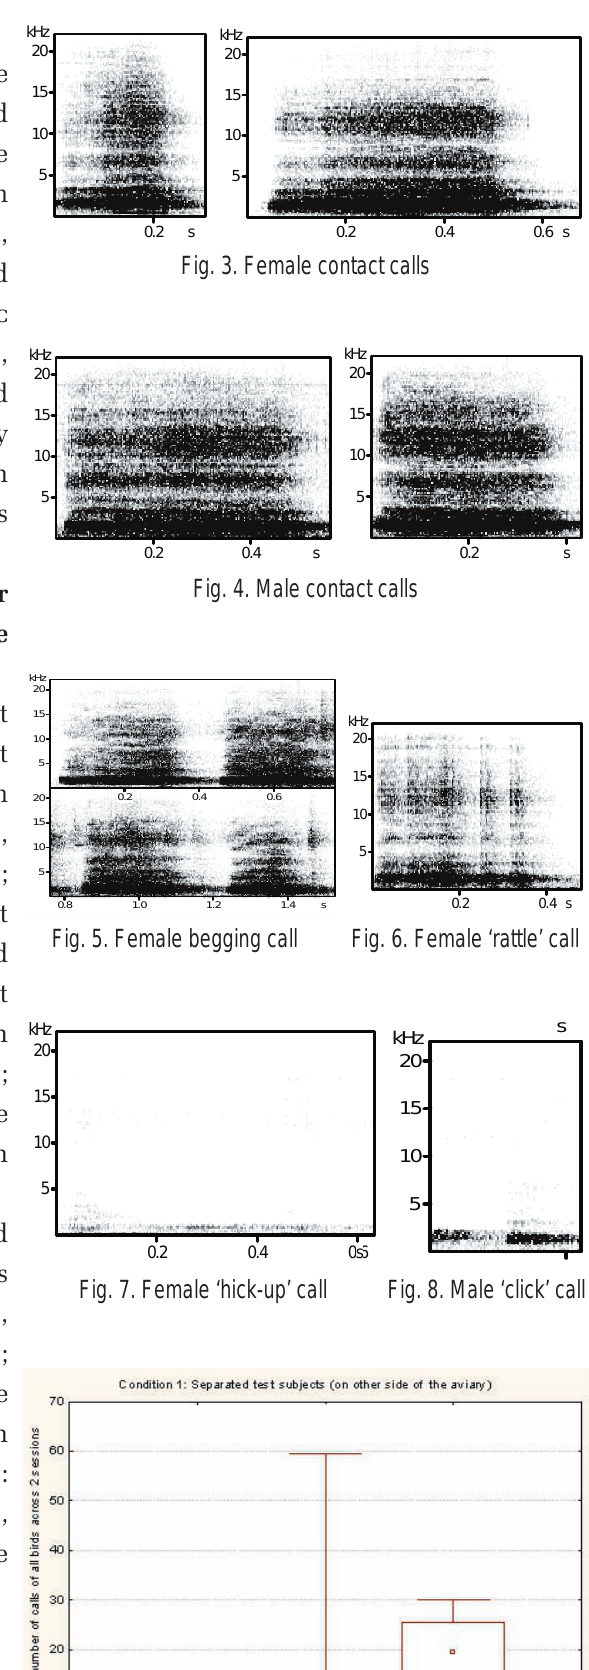
Fig. 9. Box and whisker plots for the calls given by the test subjects in the three phases in condition 1. Boxes show the interquartile range; the box for the observers is divided by the median value. Whiskers indicate the largest and smallest